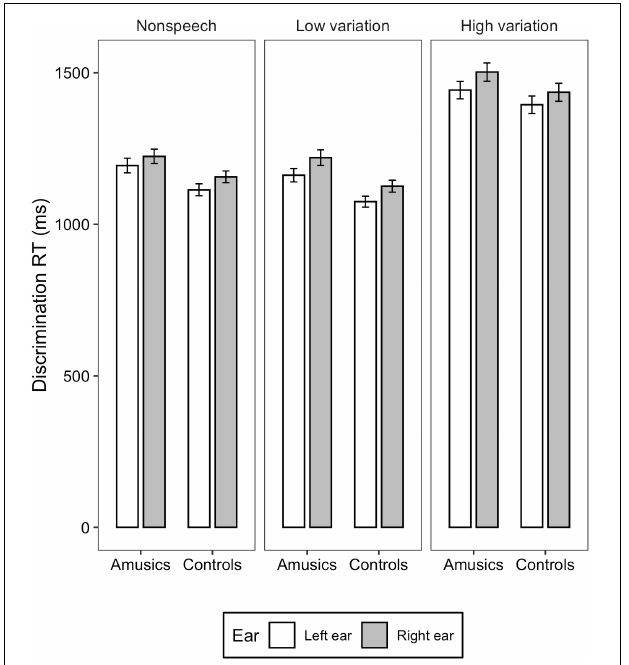
FIGURE 4 | Bar charts showing the discrimination RT (means and CIs) in each ear for amusic and control participants in the three stimulus conditions: Non-speech, Low variation, and High